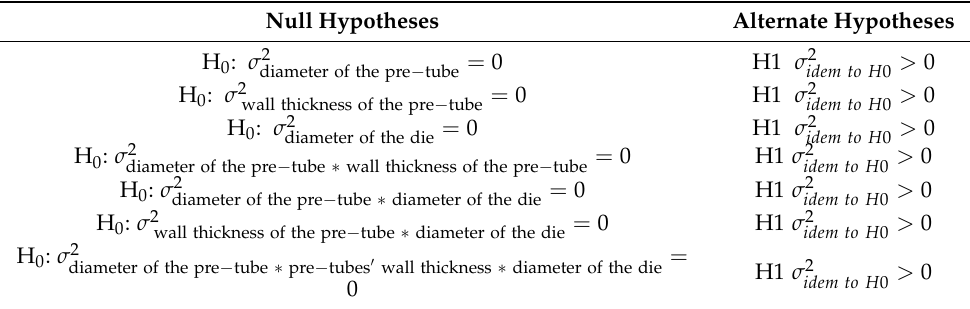
Table 10. Formulation of the hypothesis for the 23 specific factorial designs under study.